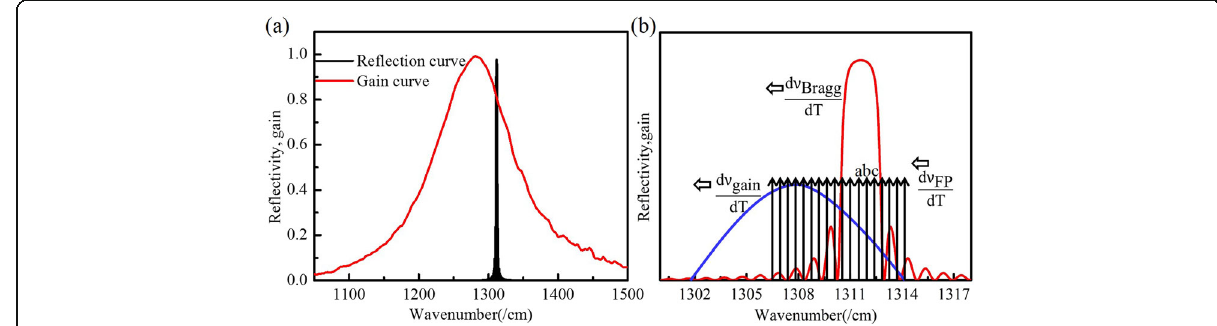
Fig. 3 a The measured wafer gain curve and calculated the reflection curve of Bragg grating based on transfer matrix method by MATLAB. b The schematic diagram of mode selection mechanism of DBR QCL